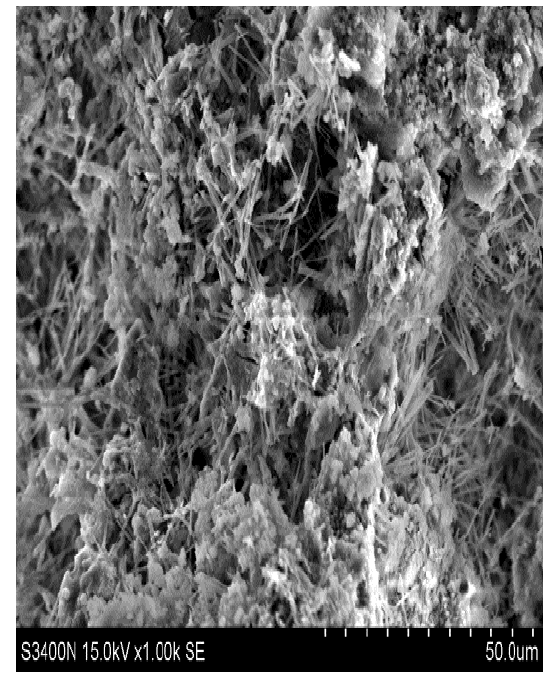
Figure 10. SEM (1000×) 5 mm beneath the surface.